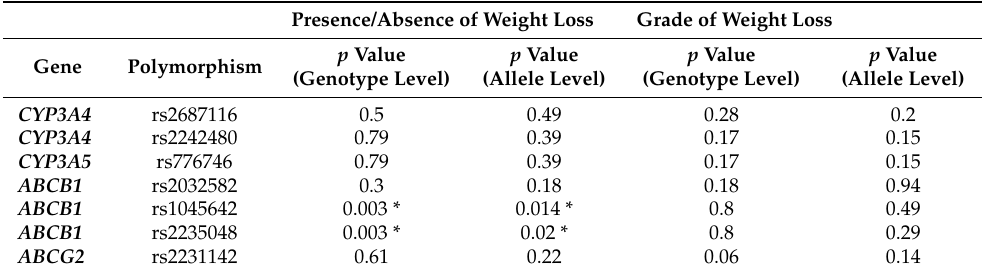
Table 10. p value by chi-squared test at genotype and allele level for weight loss. Correlation between weight loss side effect and polymorphisms linked to MKI